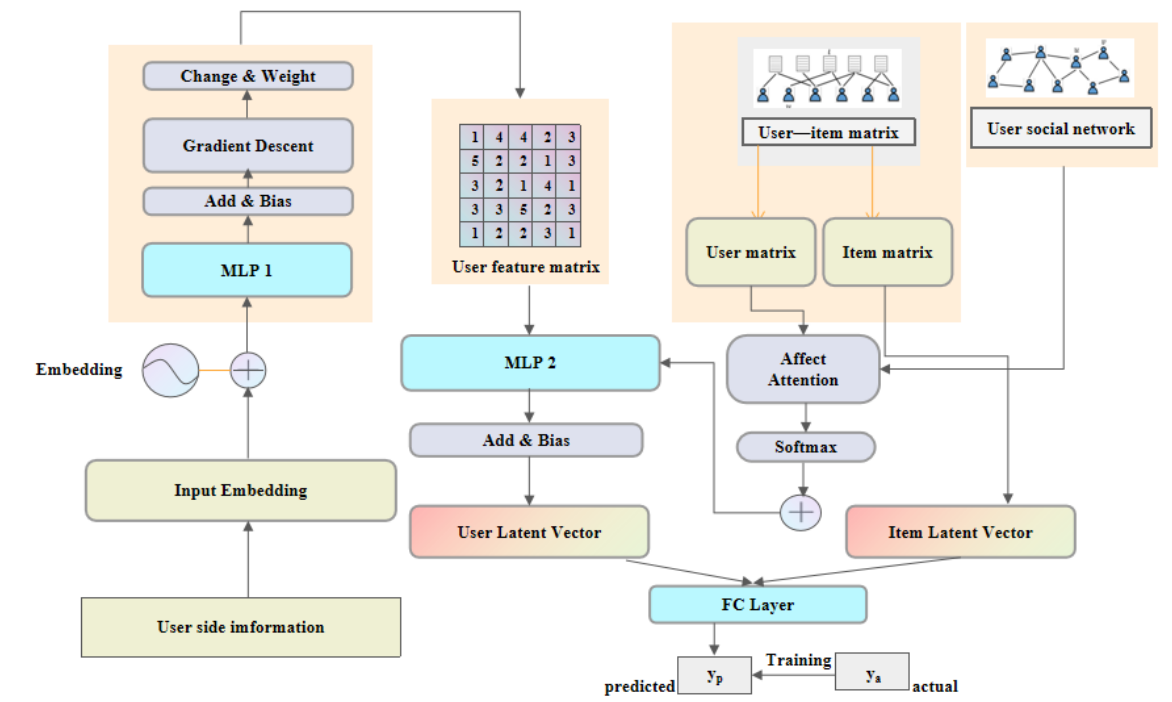
Figure 1. FSCR Model